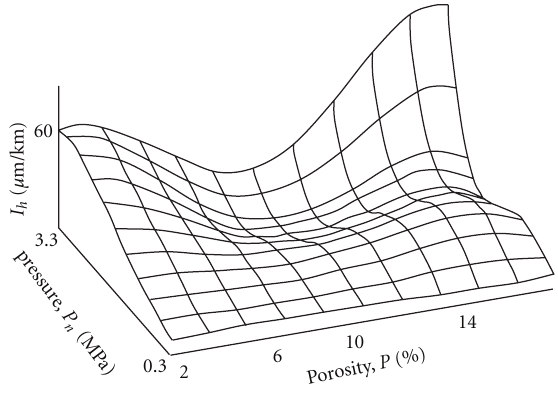
Figure 9: Response surface of I ( P , P n